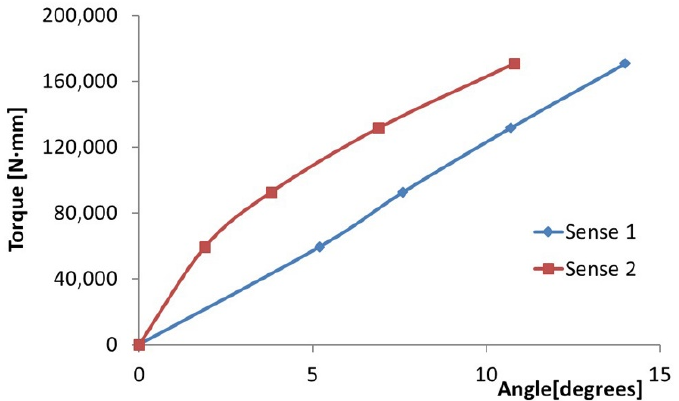
Figure 21. Variation of the angle of rotation of the arm with the torque moment.